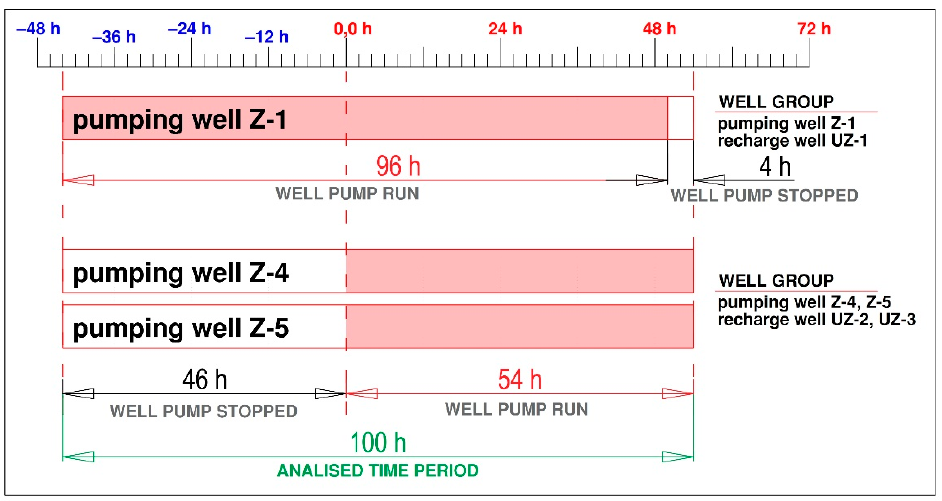
Figure 20. Pump operation schedule.